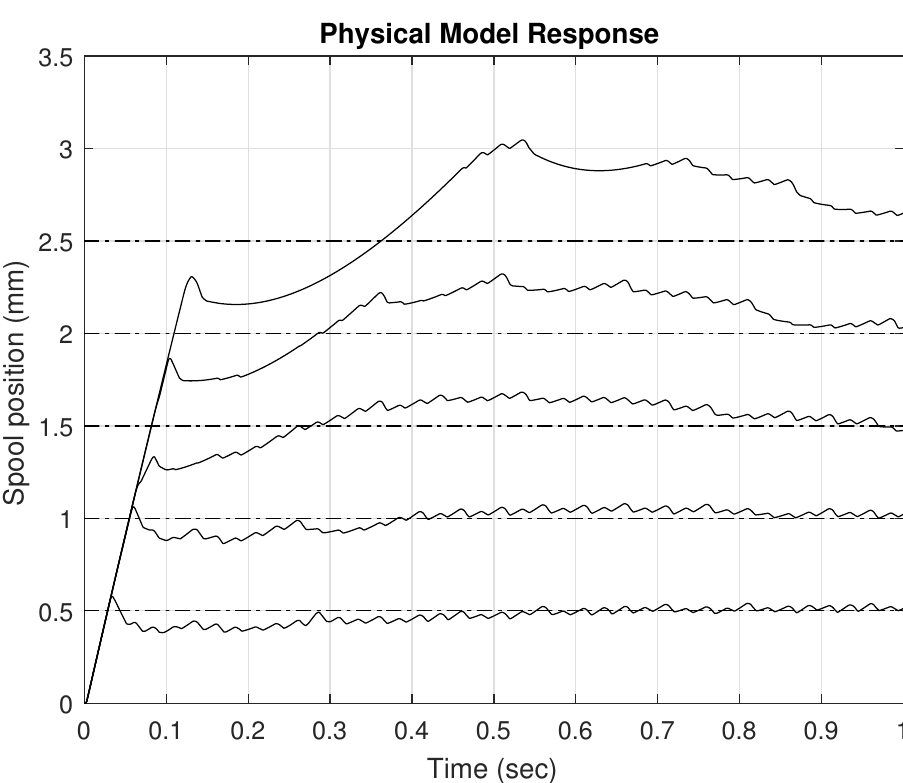
Figure 12. Spool position from the nonlinear model with the controller.